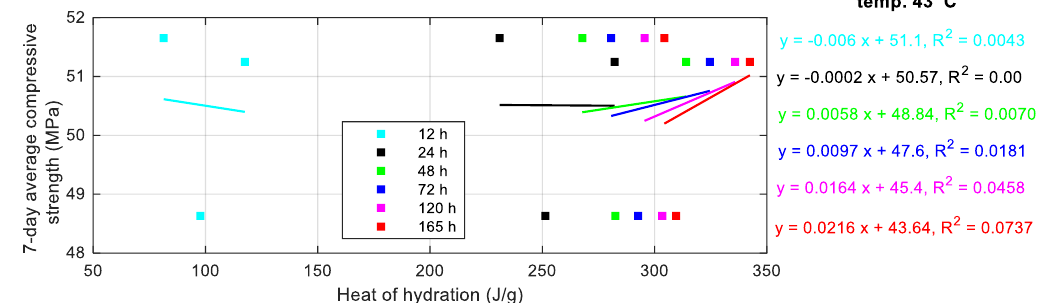
Figure 7. Correlation of 7-day strength and heat of mortars cured at 33 °C.